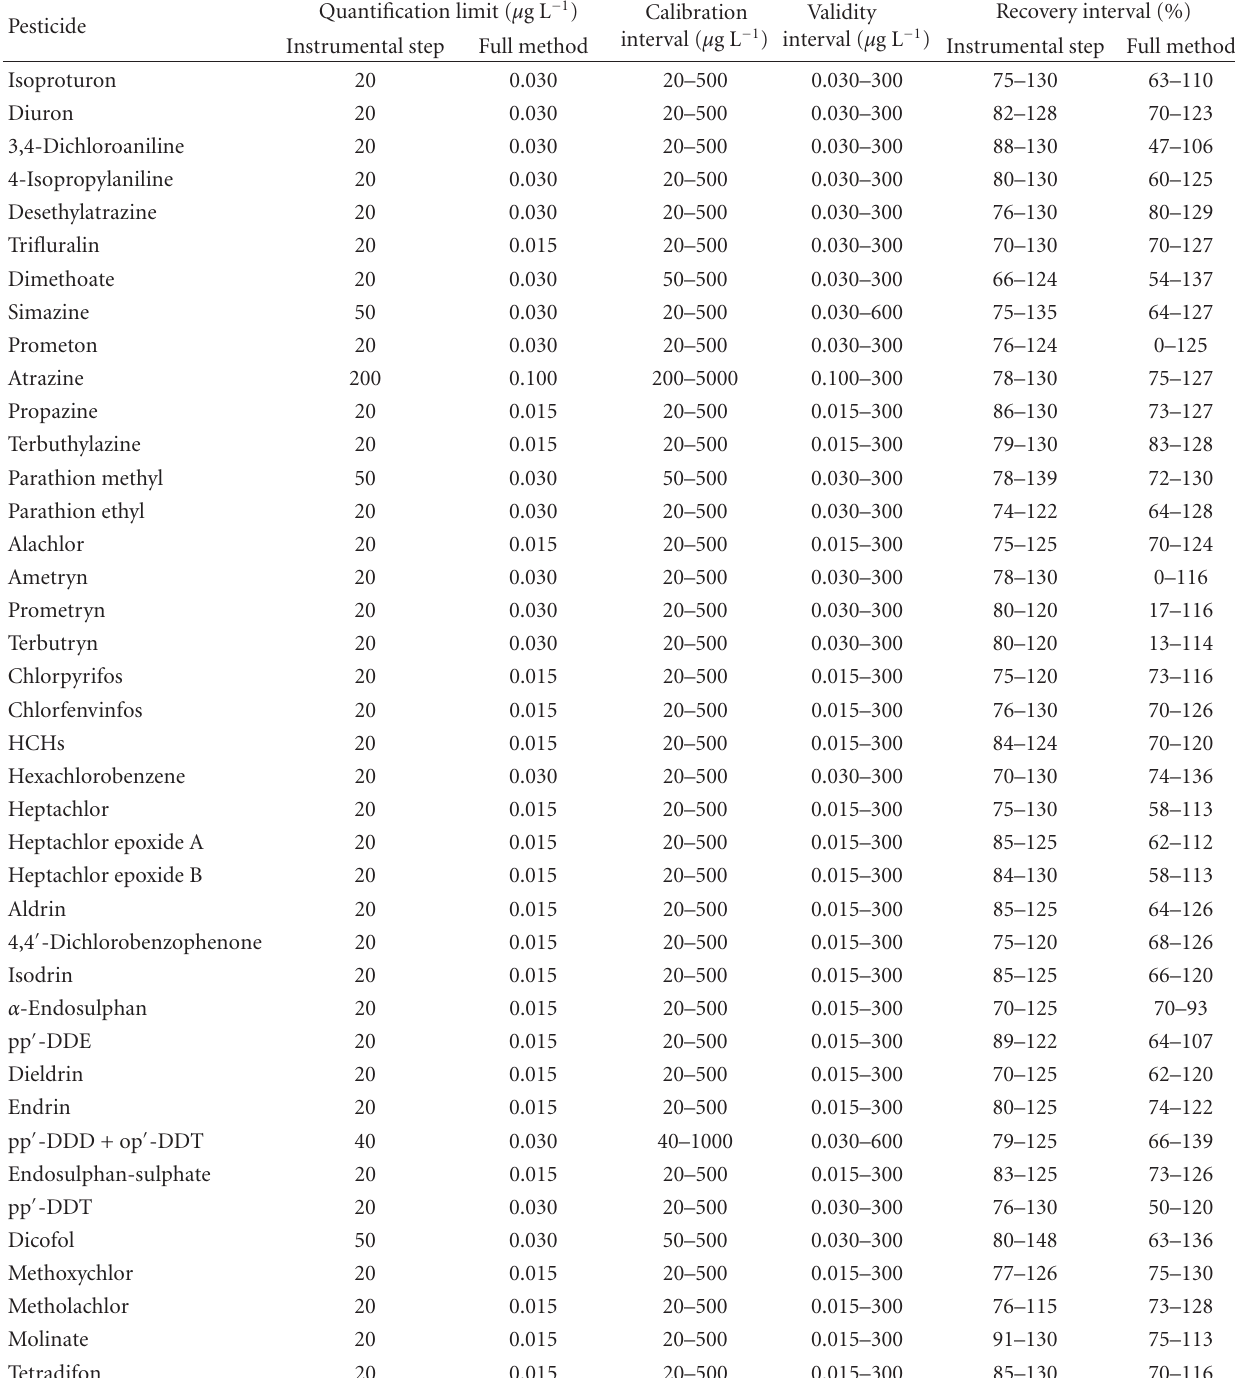
Table 3: Results of the methodology validation of the pesticide